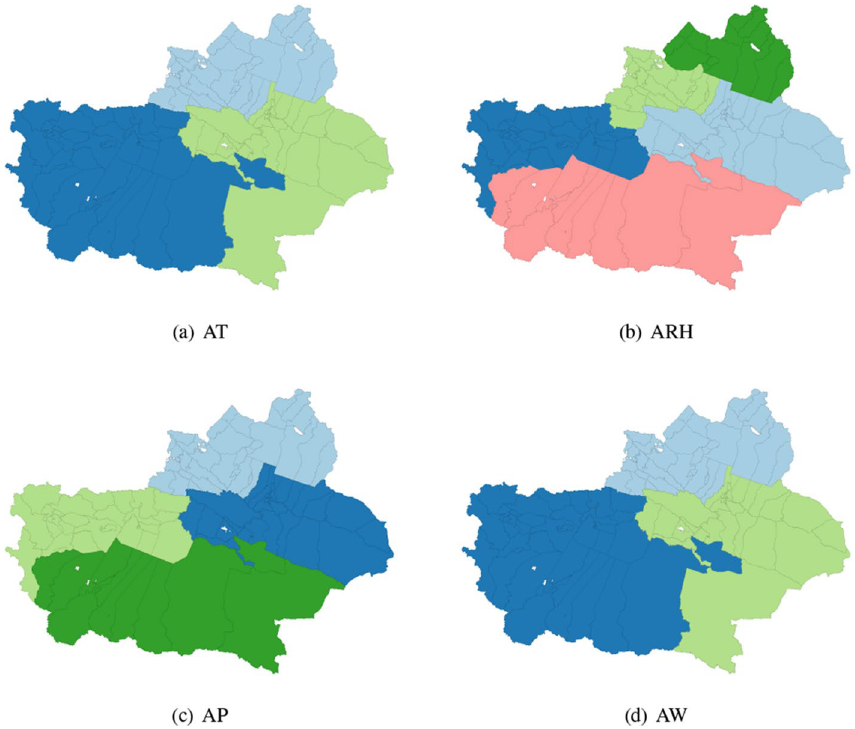
Figure 3. Spatial cluster distribution of some meteorological factors (AT, ARH, AP, AW) in Xinjiang in June